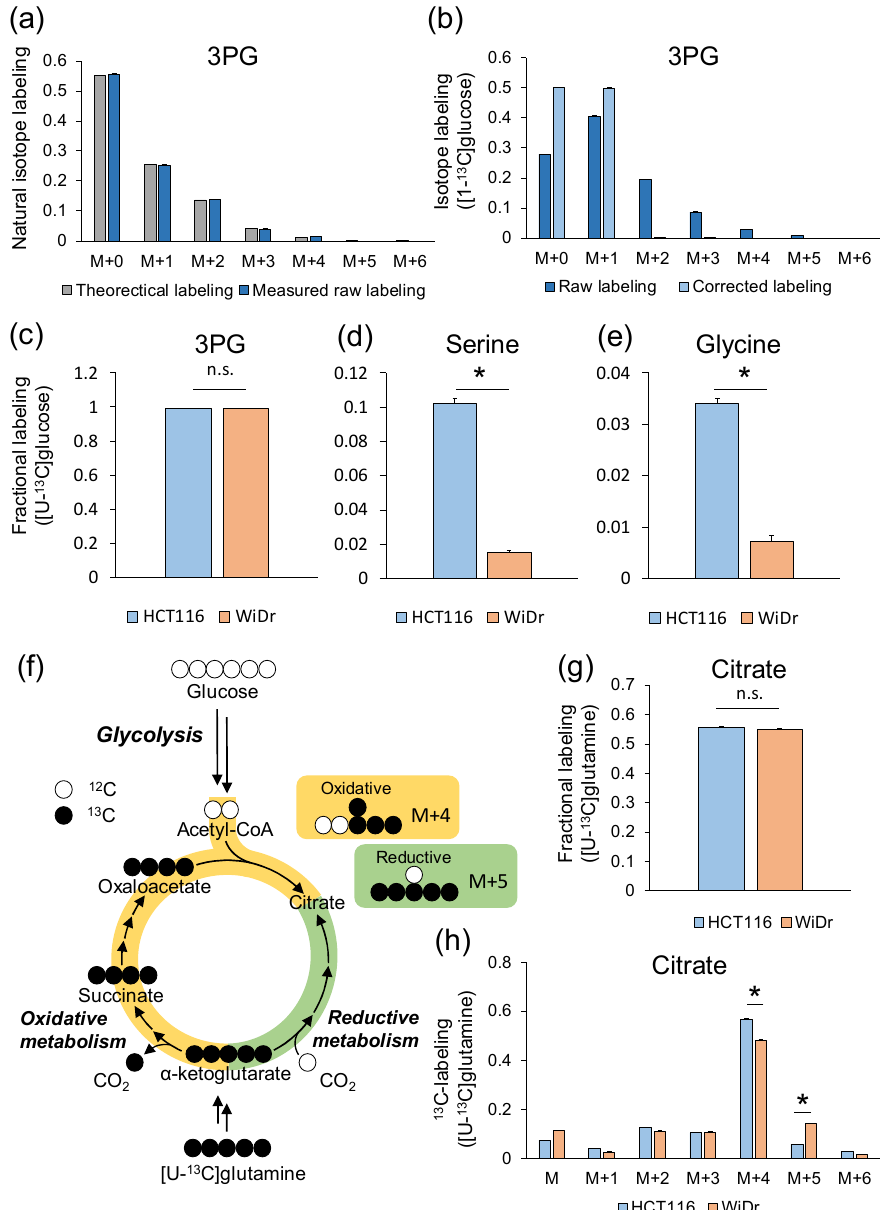
Figure 3. 13 C-labeling of intracellular metabolites in HCT116 and WiDr. ( a ) Theoretical and meas- ured raw labeling of 3-phosphoglyceric acid (3PG) obtained from HCT116 cells cultured in unla- beled medium. ( b ) Raw and corrected labeling of 3PG obtained from HCT116 cells cultured in [1- 13 C]glucose. ( c – e ) Fractional labeling of ( c ) 3PG, ( d ) serine, and ( e ) glycine in HCT116 and WiDr cells cultured in [U- 13 C]glucose. ( f ) Atom mapping of oxidative (yellow) and reductive (green) glutamine metabolism. ( g , h ) ( g ) Fractional labeling and ( h ) corrected 13 C-labeling of citrate in HCT116 and WiDr cells cultured in [U- 13 C]glutamine. Data are presented as the mean ± standard deviation ( n = 3). *, p < 0.05 in Student’s t -test. n.s., no significance. A total of 336 row labeling data (2 cell lines × 4 tracer conditions × 14 detected metab- olites × 3 repetitions; Supplementary File S2) were processed to correct the effect of natural isotopes by the natural isotope subtractor in 11 s. The isotopic steady state at the time